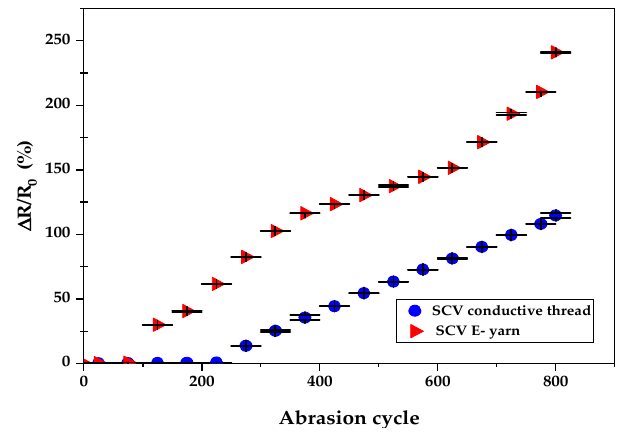
Figure 10. Effects of abrasion on electrical resistance.